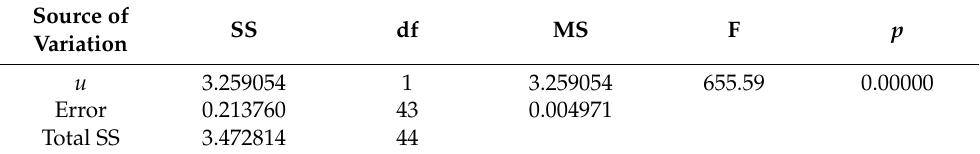
Table 4. Model of transverse shrinkage S T —ANOVA table, R 2 = 0.94; R adj2 = 0.94. Source of SS Variation